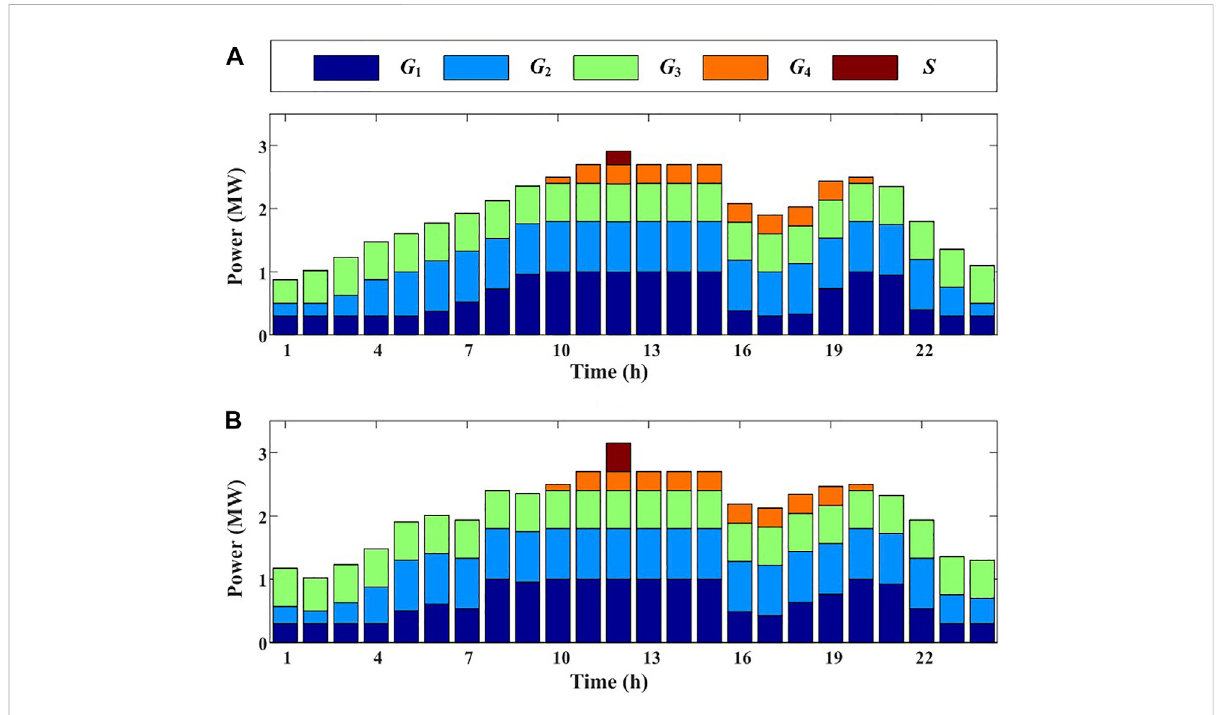
FIGURE 2 Outputs of power plants: (A) Γ wind = 0 (B) Γ wind =